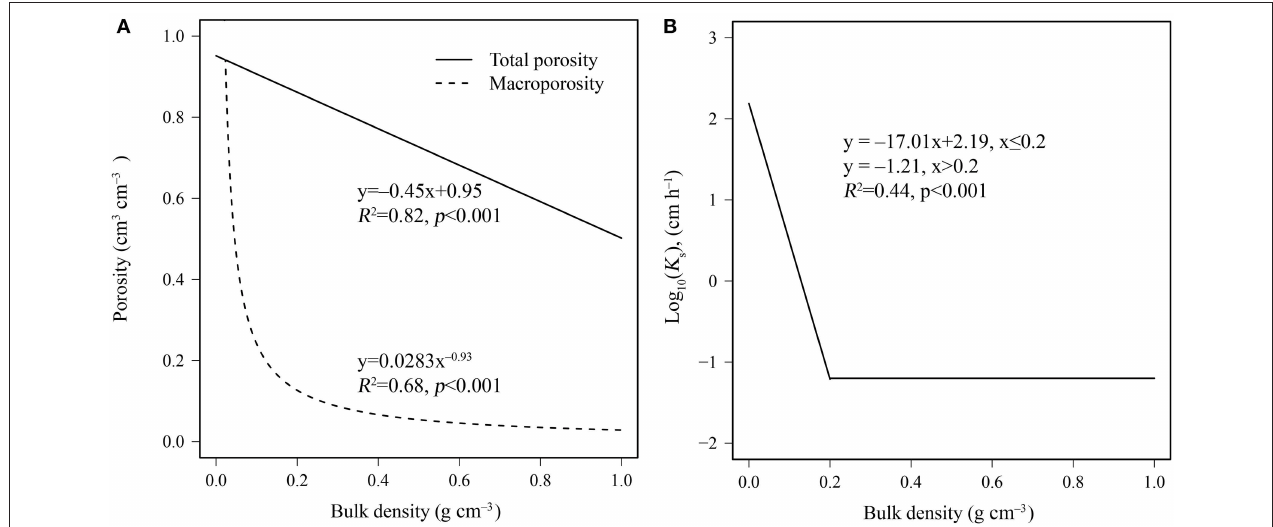
FIGURE 2 | Pore structure (total porosity and macroporosity; A ) and saturated hydraulic conductivity ( K s ; B ) of peat soils along a bulk density gradient. Data source from Liu and Lennartz (2019).